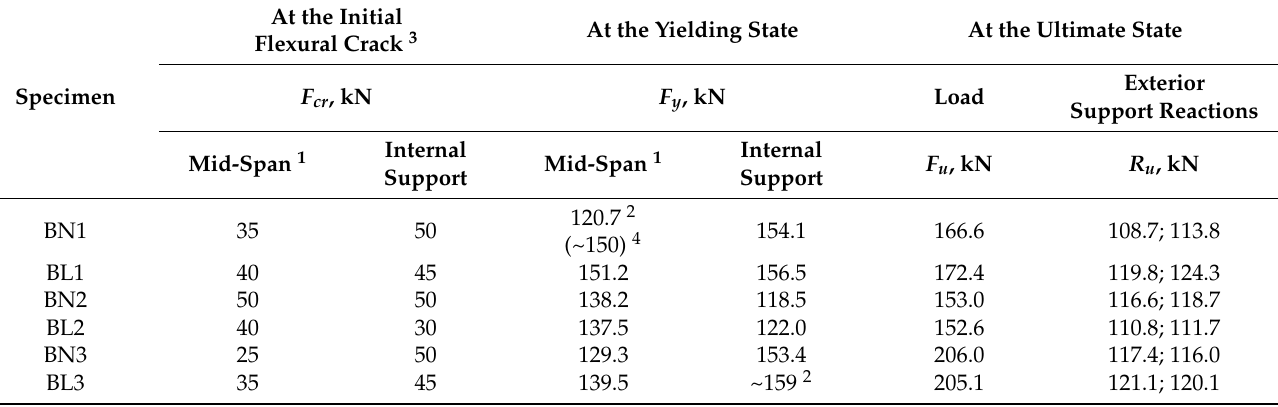
Table 5. Summary of test results.